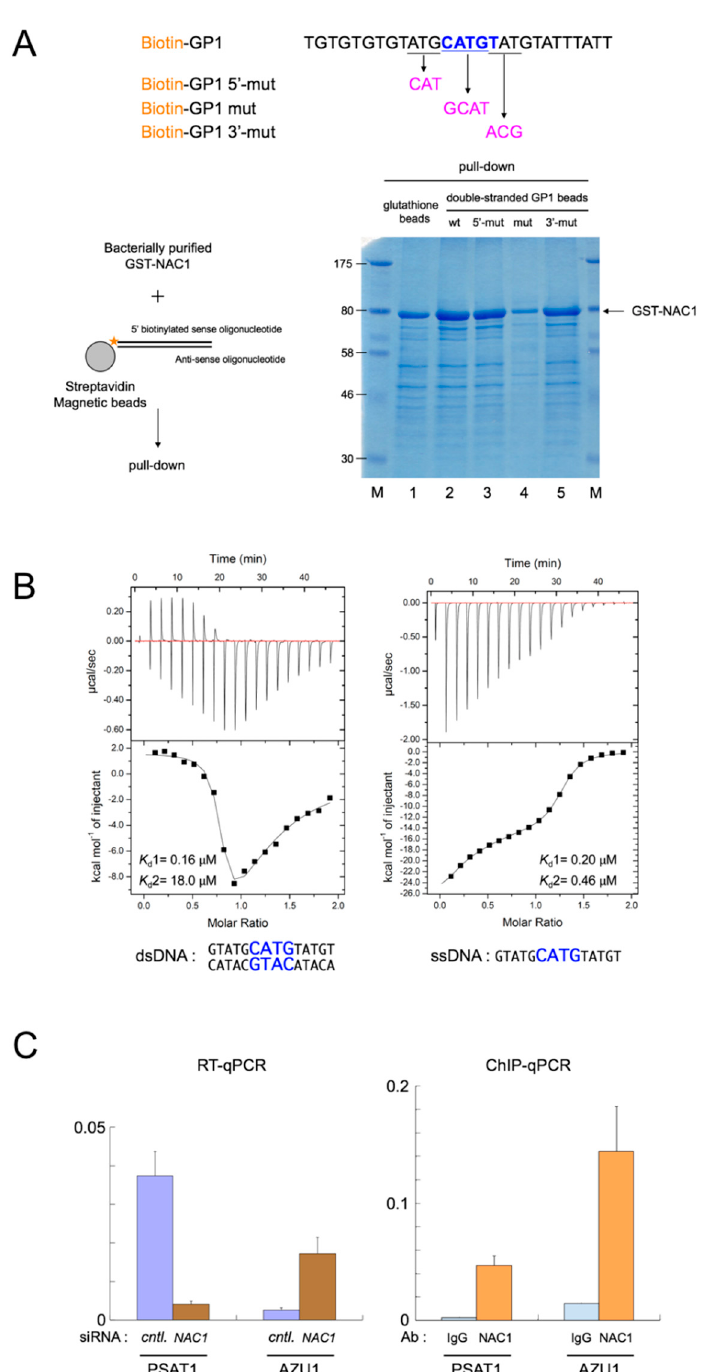
Figure 2. Characterization of the consensus DNA-binding sequence of NAC1. ( A ) Pull-down assay using dsDNA oligonucleotides for wild type and mutant probes against GADD45GIP1 promoter (Upper panel, only sense oligonucleotides are shown). Lower left panel, outline of the pull-down procedure. Lower right panel, 5 μ g of bacterially expressed and purified GST-NAC1 was mixed with biotin-labeled dsDNA oligonucleotides for wild type and mutant probes, and pull-down assays were performed. The gel was stained with Coomassie blue to detect NAC1 in the dsDNA-protein complexes pulled down by the oligonucleotides. ( B ) Isothermal titration calorimetry. Upper panels are raw titration data plotted as heat ( μ cal/s) versus time (min). Each experiment consisted of 28 injections of 10 μ L of 50 μ M dsDNA (left panel) or of ssDNA (right panel) into a solution of 500 μ M NAC-1 (322–485) at 25 °C. The lower panels are integrated heat responses plotted as normalized heat per mole of injectant. Smooth curves represent best fits of the data to the equation as described under